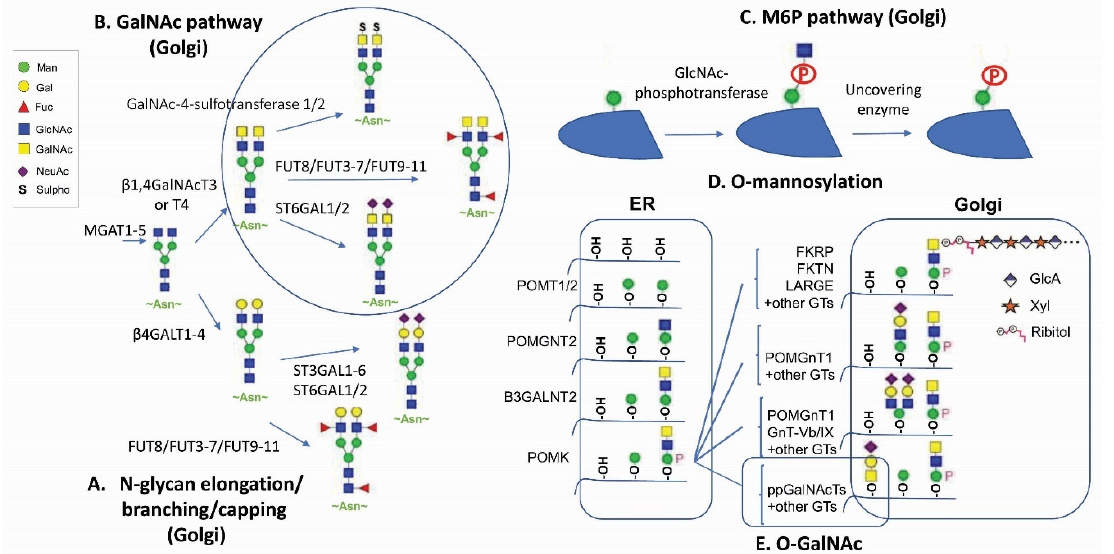
Figure 1. Major human glycan pathways. ( A ) N-glycan elongation, branching, and capping path- ways. ( B ) GalNAc pathway [14]. ( C ) M6P pathway [15]. ( D ) O-mannosylation [16]. ( E ) O-GalNAc pathway (circled).